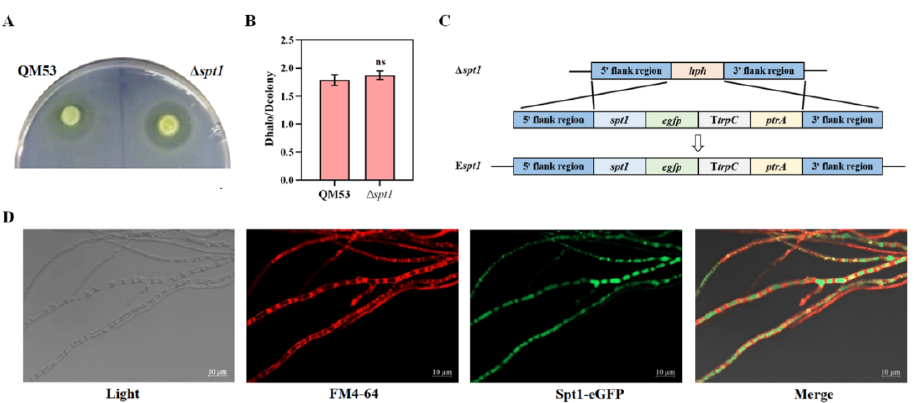
Figure 3. Subcellular localization of Spt1 in T. reesei . ( A ) Evaluation of the ability to produce extracellular proteases by the Δ spt1 strain. The strains were grown on media containing 1% skim milk. ( B ) The ratios of the hydrolysis halo to the colony diameter presented by panel ( A ). The values represent the average of three repeated measurements obtained from three different angles. The error bars refer to the standard deviations (SD). The difference between the parental strain and the deletion strain was shown by thr analysis of ANOVA followed by the Turkey test. ns = not significant. ( C ) Schematic diagram of the Spt1–eGFP fusion cassette. The cassette was inserted into the hph gene locus by homologous recombination in the Δ spt1 strain. ( D ) The vacuolar localization of Spt1 was checked out in fungal mycelia under a confocal fluorescence microscope. Scale bar = 10 µm.